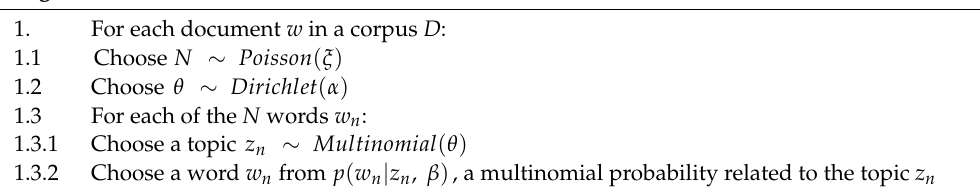
Algorithm 1 Latent Dirichlet Allocation Generative